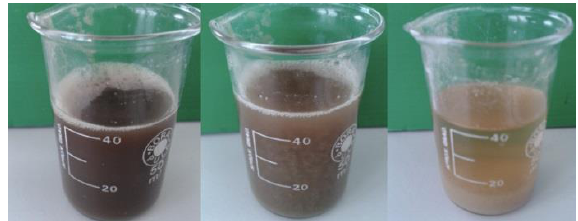
Figure 3 . Changing of compost leachate during electrocoagulation in dependence of time (left at the beginning, in the middle after 1 hour of EC and right after 1 hour of EC and 1 hour of settling) Nonlinear regression analysis of experimental data of EC process with different current and initial concentration rate constant.